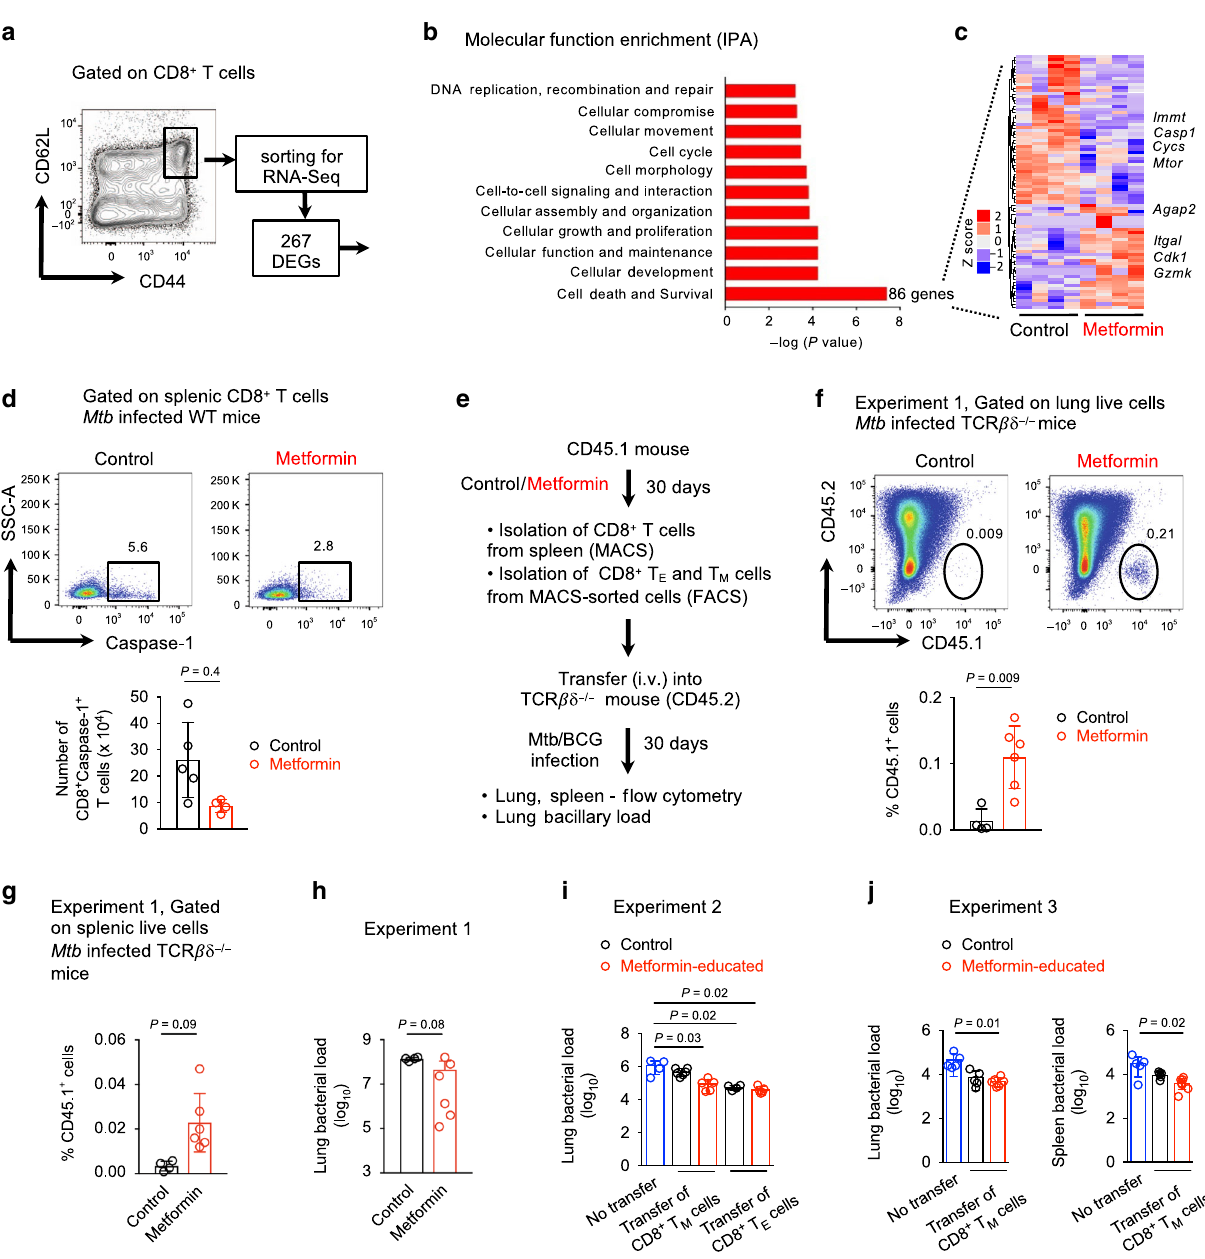
Fig. 4 Metformin reprograms gene expression of CD8 + T M cells. a Schematic depicting sorting of CD8 + T M cells for RNA sequencing and identi fi cation of DEGs in metformin-educated CD8 + T M cells. b Molecular function enrichment via Ingenuity pathway analysis (IPA) of DEGs in a . c Heat map displaying the expression level of 86 genes related to cell death and survival. d Flow cytometric analysis of caspase-1 in splenic CD8 + T cells from Mtb -infected mice treated or not with metformin. n = 5 mice/group. e Experimental set-up for the transfer of CD8 + T M or T E cells into TCR βδ − / − mice followed by Mtb or BCG infection. Three experiments were performed. f , g Flow cytometric analysis of the frequency of CD45.1 + lung f and splenic g cells in recipient mice. n = 4 control group, n = 6 metformin group. h Bacterial load in the lung of Mtb -infected TCR βδ − / − recipient mice. i , j Bacterial load in the lung of BCG- infected TCR βδ − / − recipient mice. Data of mean ± SD of 4 – 5 mice per group, Kruskal – Wallis test with Dunn ’ s multiple correction. Data in d , f , g , and h is presented as mean ± SD, two-tailed Mann – Whitney U